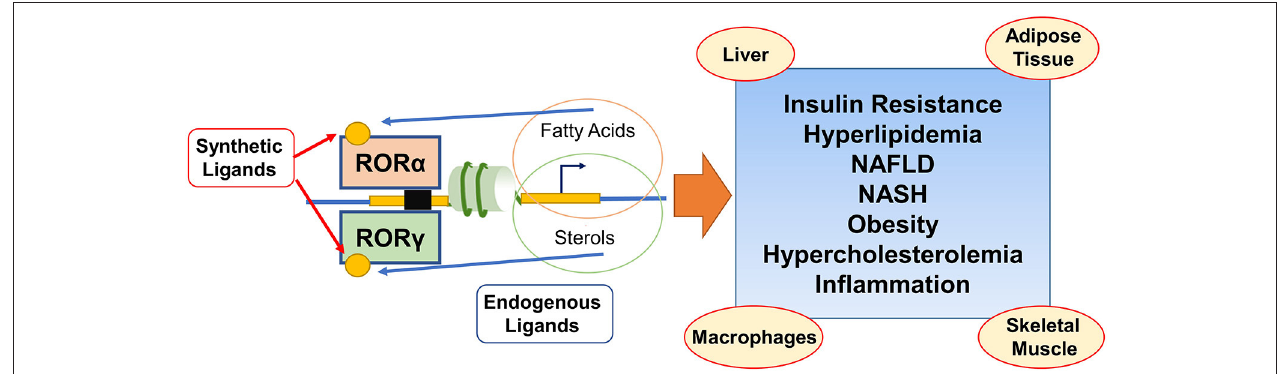
FIGURE 1 | Schematic illustration depicting that coordinated actions of ROR α / γ on lipid and sterol metabolic programming during the development of the metabolic syndrome and related disorders. Both ROR α and ROR γ regulate the target genes involved in lipid/sterol metabolism through ROR response elements and are exciting modulators in metabolic syndrome and related disorders in multiple tissues. RORs (ant)agonists from endogenous or synthetic generation, act as the potential prosects in the treatment of insulin resistance, hyperlipidemia, NAFLD, NASH, obesity, hypercholesterolemia, and inflammation.